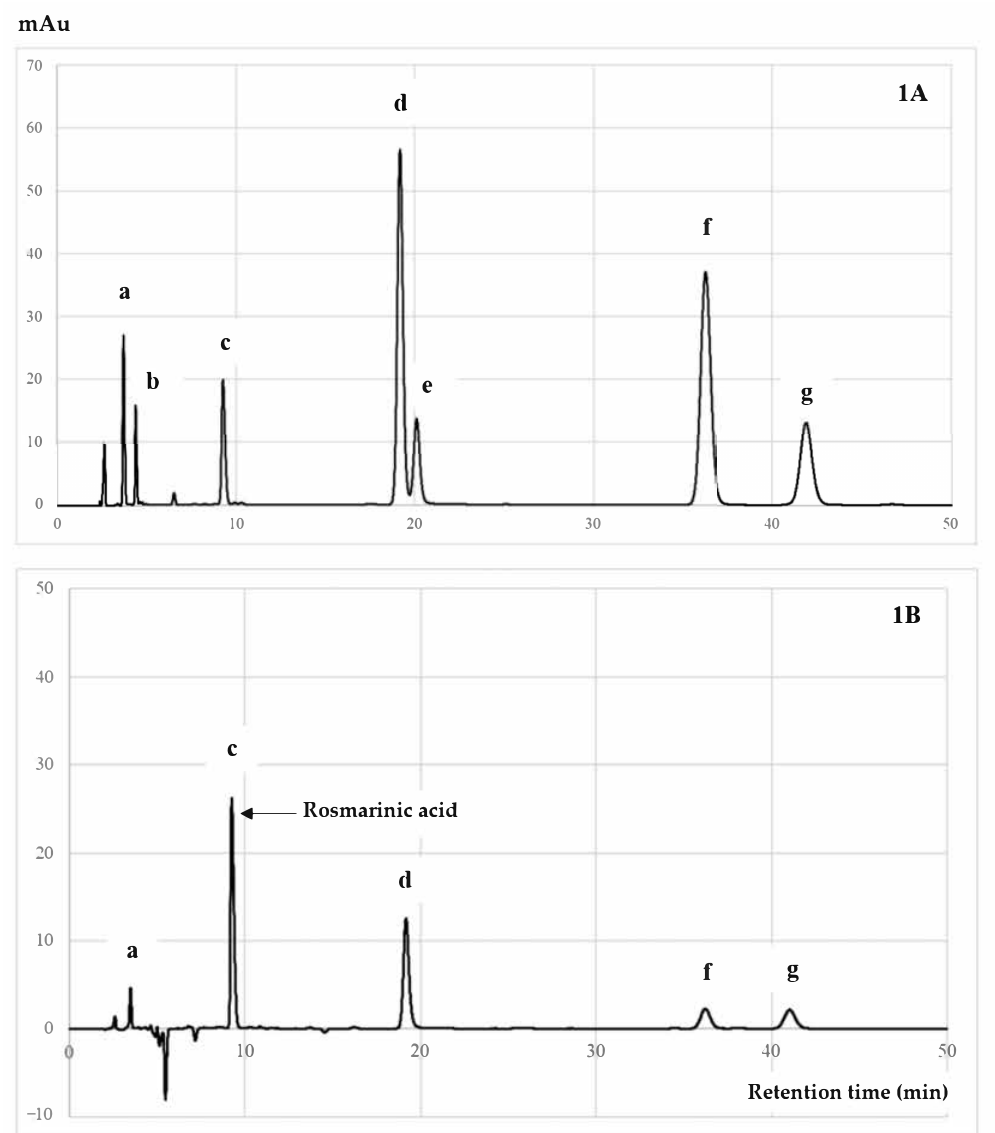
Figure 1. HPLC chromatogram of ( A ) mixed standards and ( B ) SMEF: ( a ) caffeic acid; ( b ) rutin; ( c ) rosmarinic acid; ( d ) luteolin; ( e ) quercetin; ( f ) apigenin; ( g )